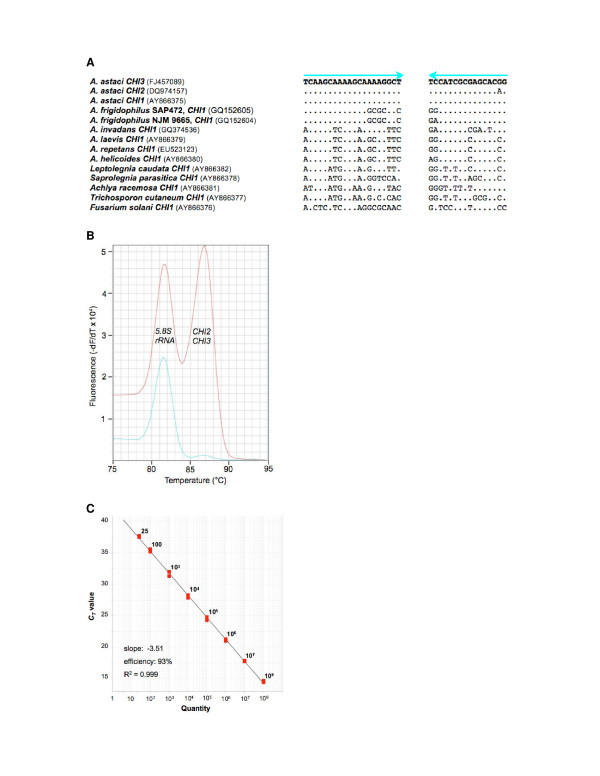
Qualitative and quantitative detection of the oomycete A. astaci. A: Diagnostic qPCR/MCA primers (blue arrows) target A. astaci-specific sites in the homologous chitinase genes CHI1, CHI2 and CHI3, but not homologous sequences of related oomycetes and fungi. Parentheses contain GenBank accession numbers. Dots and letters represent identical and substituted nucleotides compared to the A. astaci sequence, respectively. B: Qualititative detection of A. astaci by qPCR/MCA. The left and right peaks are derived from amplification of the endogenous control, and the chitinase genes CHI2 &CHI3, respectively. Red plot: A. astaci, blue plot: A. frigidophilus. C: Quantitative detection of A. astaci by TaqMan qPCR. The standard curve of the assay demonstrates quantification down to 25 copies.